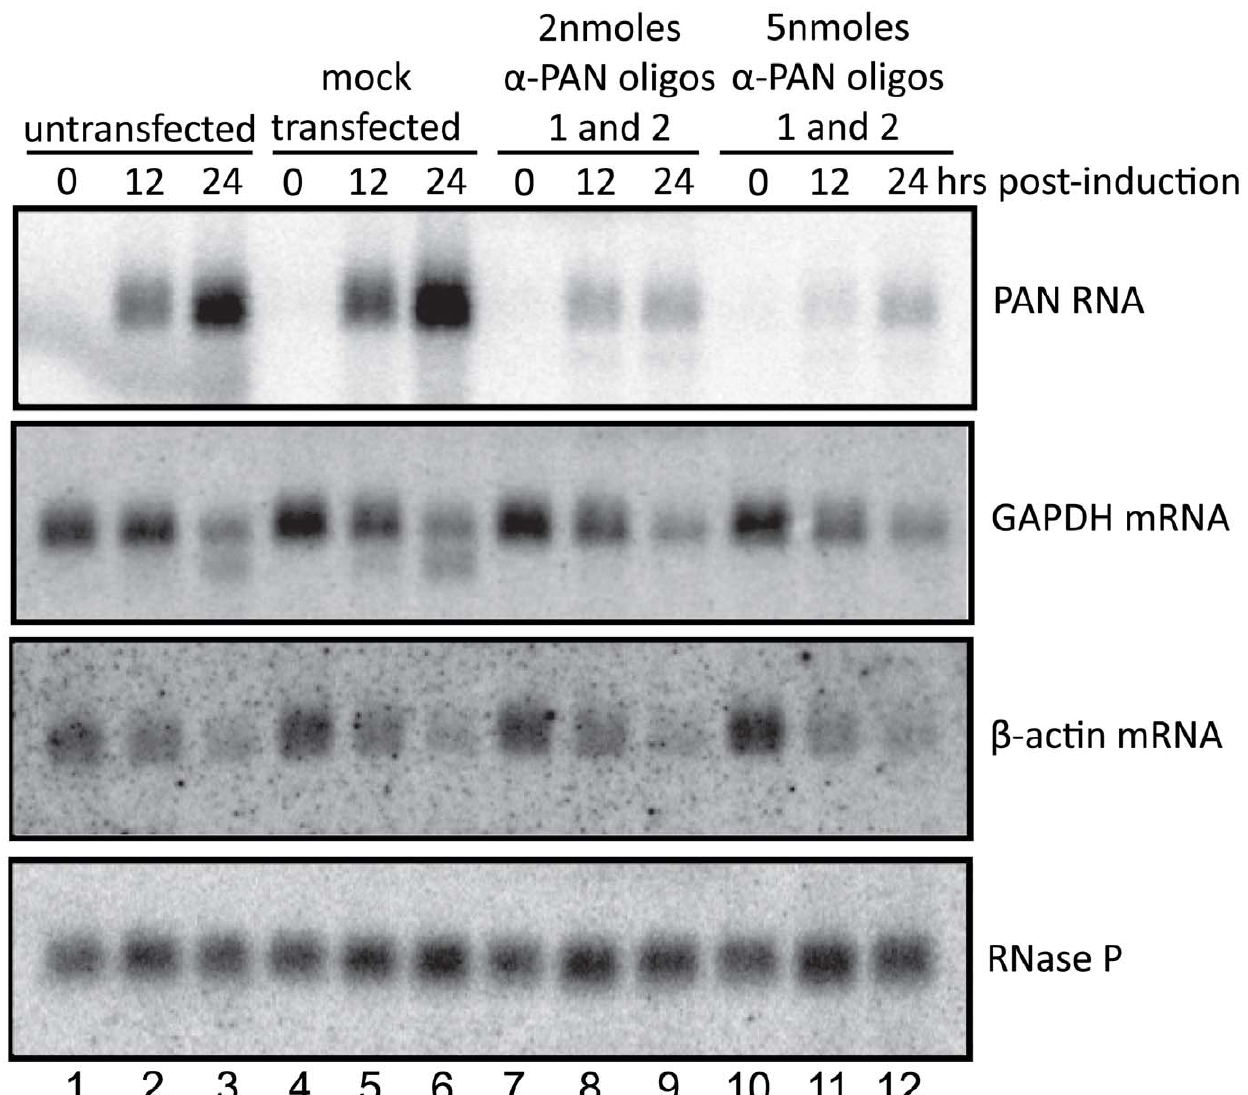
Figure 5. PAN RNA does not contribute to the host shutoff effect. Northern blot of total RNA harvested from BCBL1 TReX-RTA cells electroporated with increasing concentrations of a -PAN RNA 1 and 2 oligonucleotides at various times after doxycycline-mediated induction, probed for the RNAs indicated on the right. The faster migrating band in lanes 3 and 6 of the GAPDH panel is residual 32 P-labeled anti-PAN RNA probe.